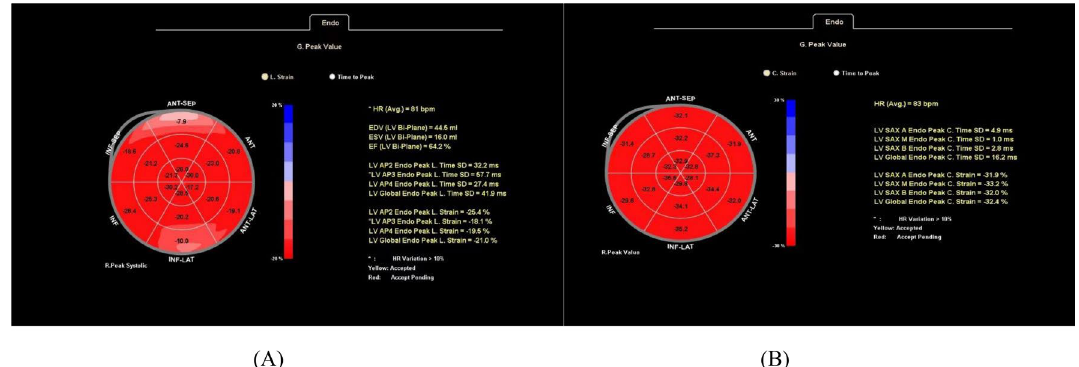
Figure 3. Bovine eye diagram of healthy control group. Bovine eye diagram of left ventricular longitudinal strain ( A ). Bovine eye diagram of left ventricular circumferential strain ( B ).